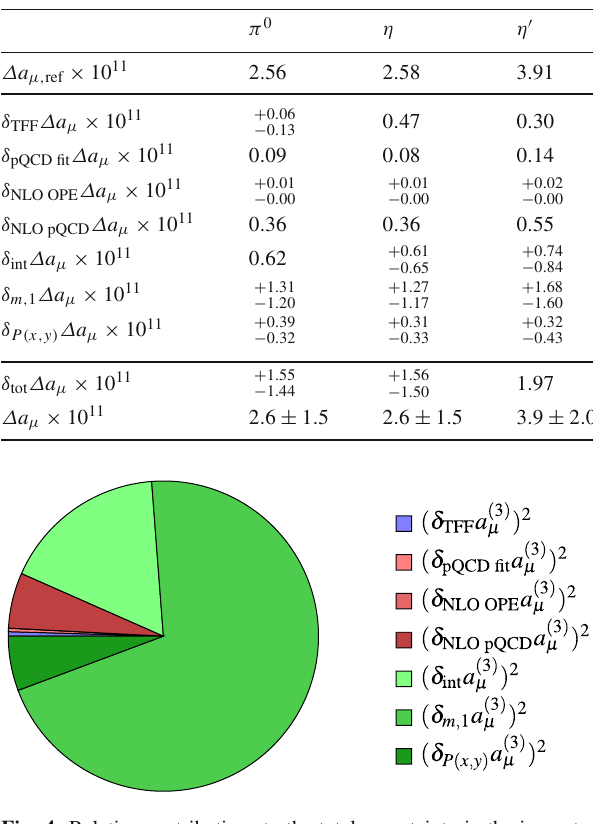
Fig. 4 Relative contributions to the total uncertainty in the isovector channel. For asymmetric errors the mean of the squared errors is